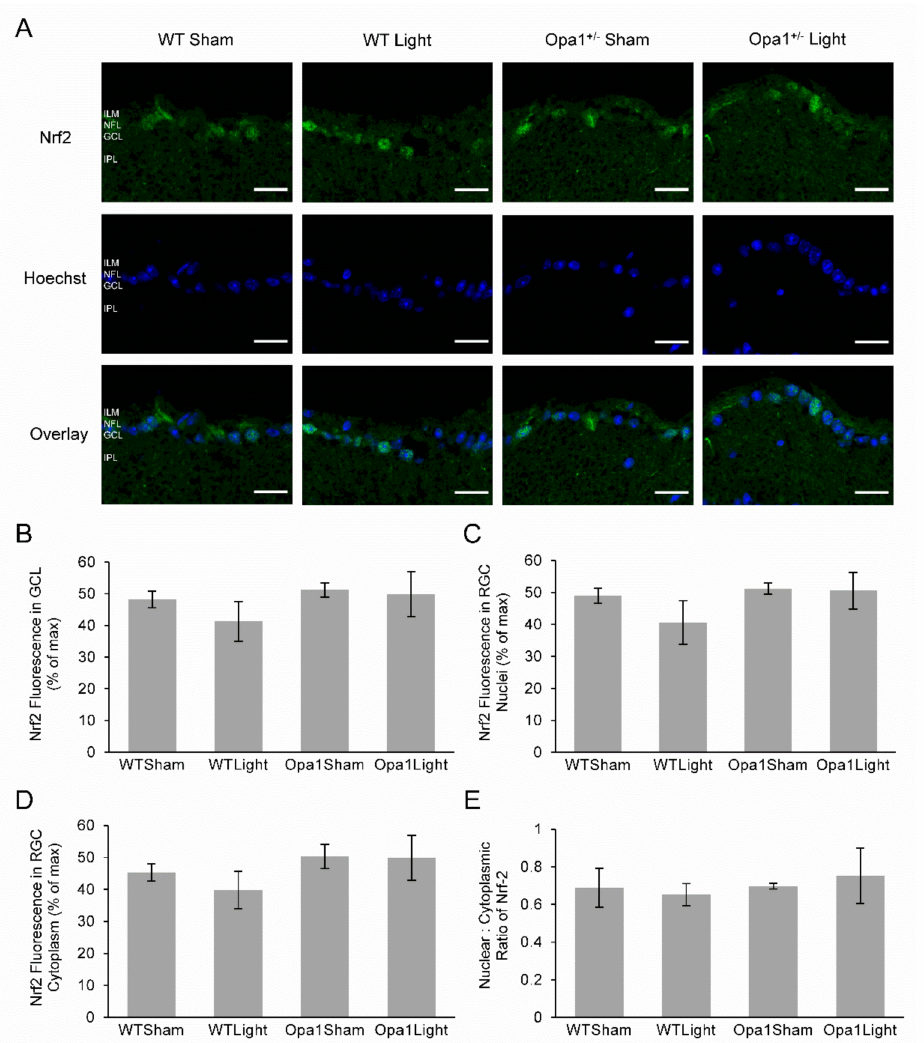
Figure 5. Immunohistochemical analysis of Nrf-2 expression. ( A ) Representative microscope images showing cross-sections of the GCL at 60 × magnification. Nrf-2 staining is shown in the top row, while the middle row shows the nuclear stain, and the bottom row contains overlays of the two stains. ILM: inner limiting membrane; NFL: nerve fiber layer; GCL: ganglion cell layer; IPL: inner plexiform layer. Scale bar represents 20 µ m. ( B – E ) The Nrf2 fluorescence was quantified over the whole of the GCL, as well as specifically within the nuclear and cytoplasmic compartments in order to analyze the nuclear: cytoplasmic ratio as a measurement of Nrf2 activation. WT Sham ( n = 3), WT Light ( n = 5), Opa1 +/ − Sham ( n = 5) and Opa1 +/ − Light ( n =